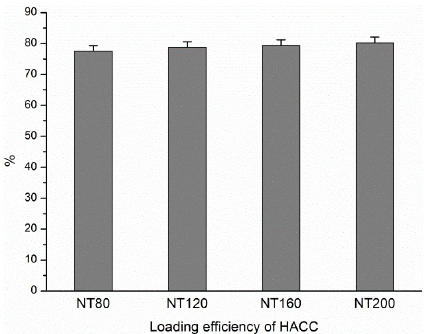
Figure 1. Loading efficiency of HACC in nanotubes with different diameters.